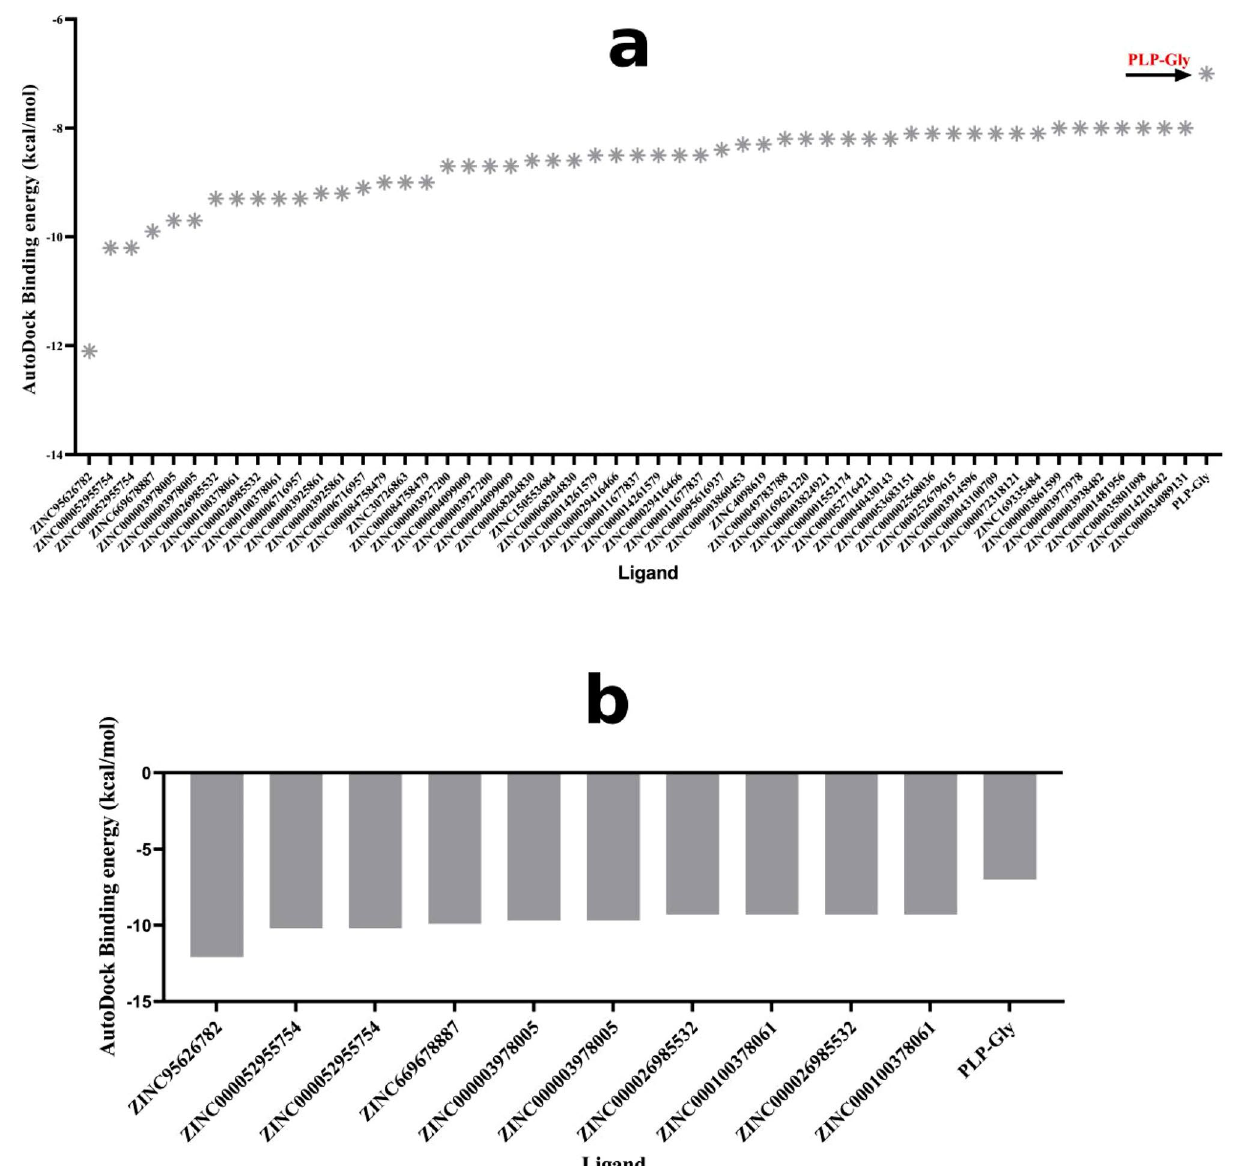
Figure 5. Screening of ligand library against the w ALAS. ( a ) Binding energies of the top 50 candidates, compared to PLP-Gly ( b ) The top performing candidates with < − 9 kcal/mol binding Asn-52, Cys-108, Asn-237, Thr-239, Leu-240, and Val-358. The strongest favourable energy contributions to nilotinib complexation are from Asn-52, Glu-179, Asp-208 and Gln-237. The active site residues Phe-24, Tyr- 110, and Met-184 also contribute strongly to the interactions between paritaprevir and w ALAS. Generally, the interactions between w ALAS and the ligands are stabilized by minor contributions from many active site resi- dues. The largest non-favourable energy contribution towards the binding of nilotinib and paritaprevir is from Lys-242. This lysine residue is conserved in all ALAS proteins and aid in catalysis by positioning the co-factor appropriately in the active pocket for catalysis to occur 20 . The energy contribution profile also suggests a minor favourable energy contributions from Lys-242 (− 1.2 kJ/mol) towards the binding of PLP-Gly. Conformational changes of wALAS upon binding of drug candidates. Next, we investigated the structural dynamics of w ALAS upon binding and interactions with the drug candidates. A 200 ns molecular dynamics (MD) simulation of the complexes was performed. The structural changes of the w ALAS were charac- terized by root-mean-square-deviation (RMSD) and root-mean-square fluctuation (RMSF). The RMSF analysis was performed with the last 150 ns of the simulation. We used the conformational profile of the apoenzyme ( w ALAS without PLP-Gly) as reference to determine the resulting changes upon ligand binding. The evolution of the structural stability (RMSD) during the 200 ns MD simulation of the complexes are shown in Fig. 9a. The w ALAS recorded an average RMSD of 0.7 nm, which is lower than the RMSD upon binding of